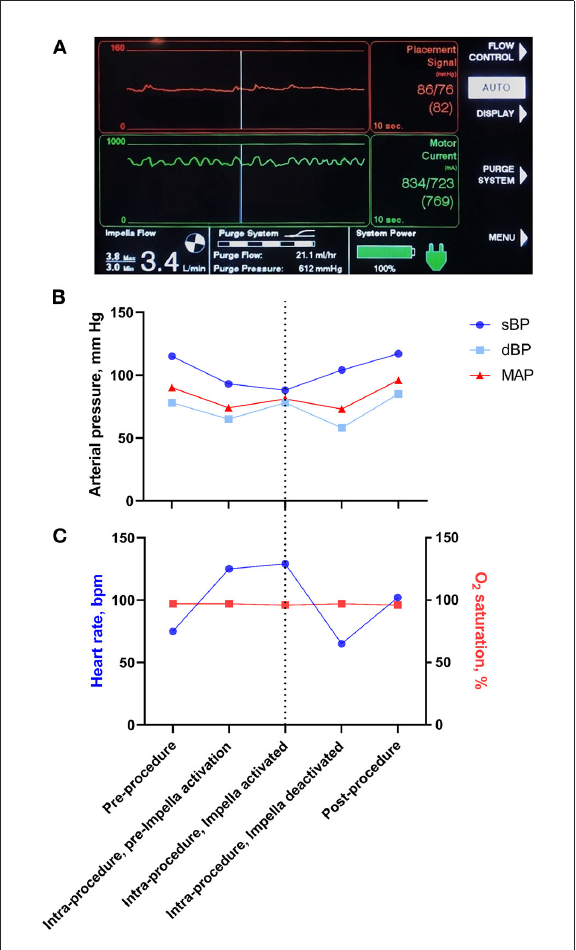
FIGURE4 Impella read out and changes in physiological parameters during the cell infusion procedure. (A) Screen capture of the Impella console during the intracoronary cell infusion during a balloon occlusion of the coronary artery. The red upper panel is a measurement of blood pressure from the Impella device and demonstrates maintenance of mean arterial pressure despite a reduction in pulsatile flow. The green middle panel demonstrates the load on the Impella motor. The bottom left panel demonstrates an Impella Flow of 3.4 L/min. (B) Schematic representation of changes in blood pressure during the Impella-assisted cell infusion procedure. Systolic blood pressure (sBP), diastolic blood pressure (dBP) and mean arterial pressure (MAP) are shown before, during and after Impella activation. The dotted line represents the time at which cells were infused whilst the Impella was running. Note that Impella device augmented the MAP at the time of cell infusion. (C) Schematic representation of changes in heart rate and O 2 saturation during the Impella-assisted cell infusion procedure. The dotted line represents the time at which cells were infused whilst the Impella was